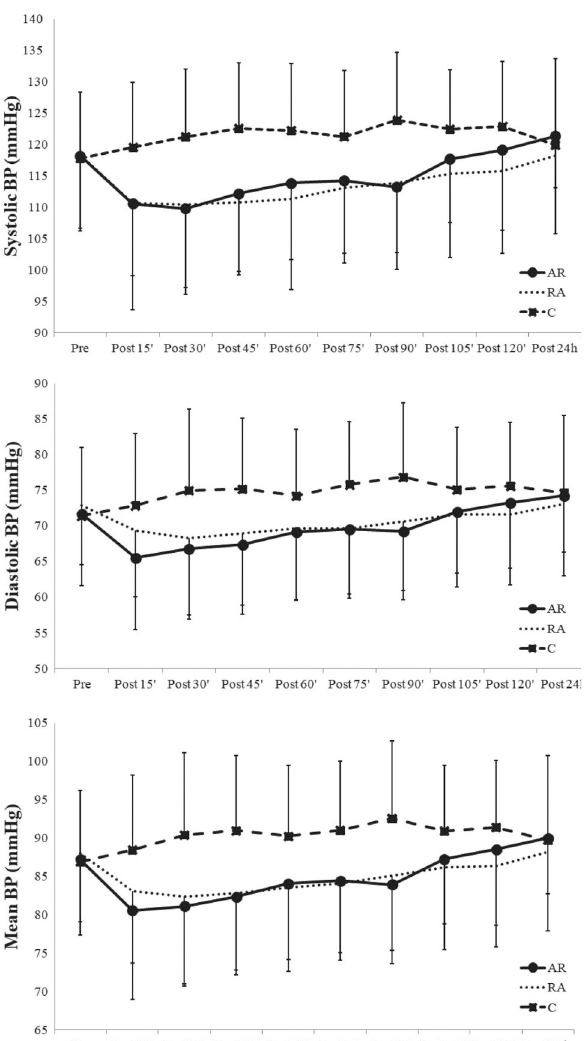
Figure 2 - Behavior of Systolic, Mean, and Diastolic Blood Pressure (BP) after a concurrent exercise session in aerobic-resistance (AR), resis- tance-aerobic (RA), and control (C) order. ∗ difference in the AR session in relation to pre-exercise, # difference in the RA session in relation to pre-exercise, § difference in the C session in relation to pre-exercise, & difference in the C session in relation to the other sessions, $ difference between the RA session and the C session, α difference between the AR session and the